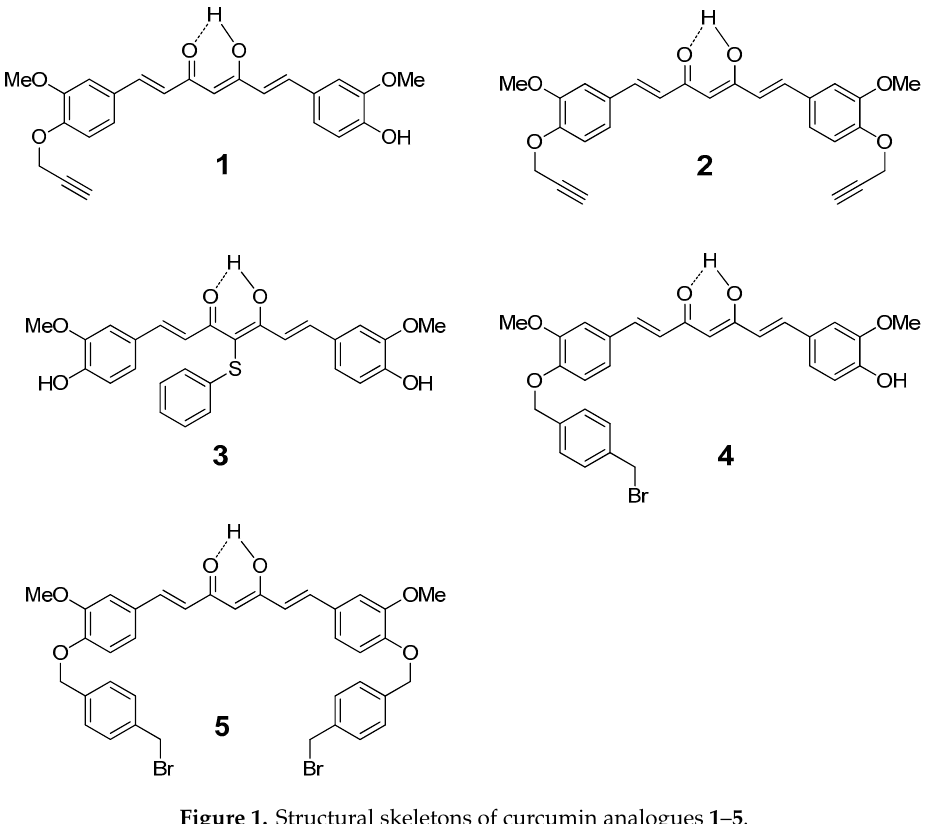
Figure 1. Structural skeletons of curcumin analogues 1 – 5 .